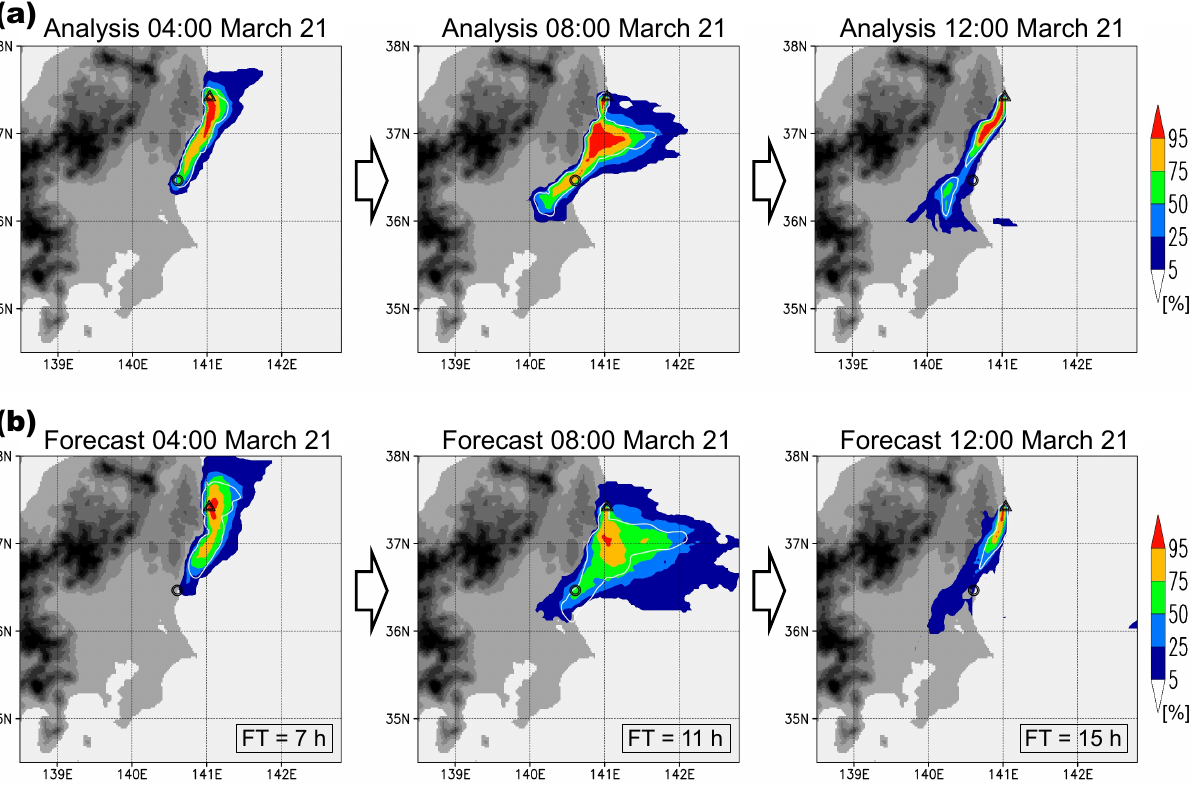
Figure 7. Same as Figure 4 but for 21 March. The local time of the snapshots was 4:00, 8:00, and 12:00 on 21 March, respectively. In the lower panels, the forecast duration was 7, 11, and 15 h, re- spectively.